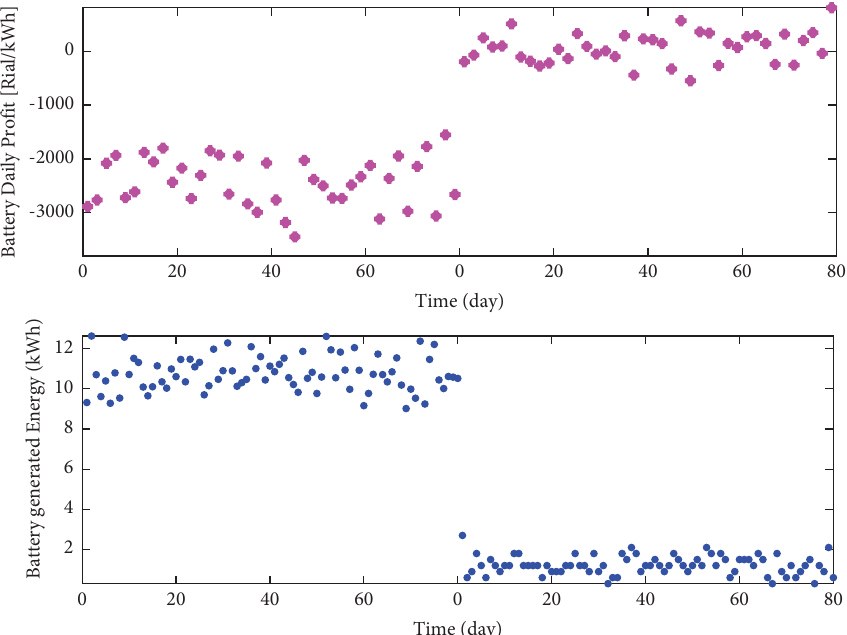
Figure 9: Average daily proft and generated power of the battery.